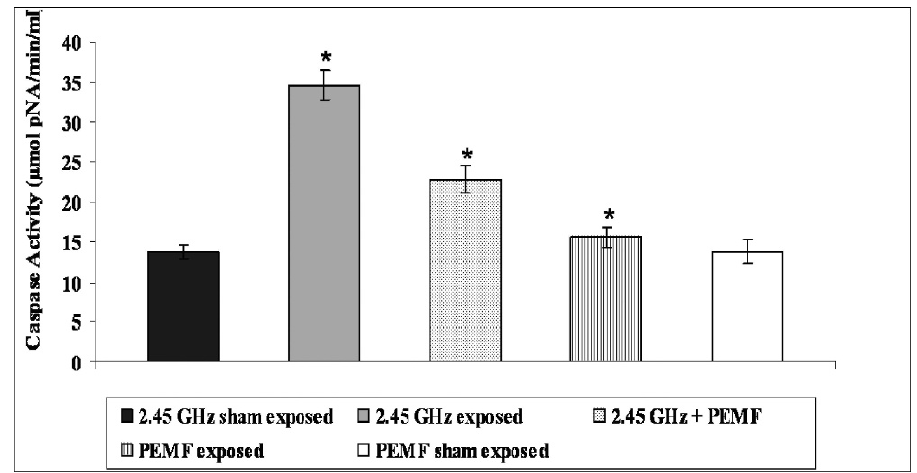
Figure 7 - The responses of the sperm caspase activities to an electromagnetic field. Caspase 3 activity was measured after overnight incubation (expressed as m mol of released pNA per min per ml of sperm lysate). The values are means ¡ SEMs. *, significantly ( p , 0.05, Fisher’s test) different from its respective sham